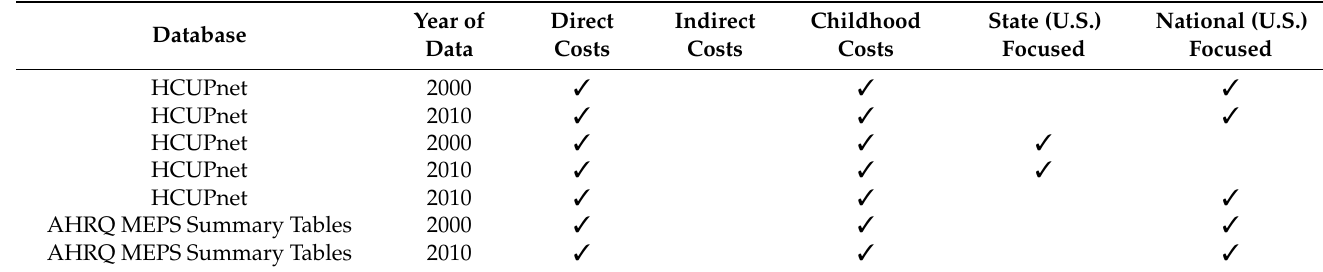
Table 2. Database